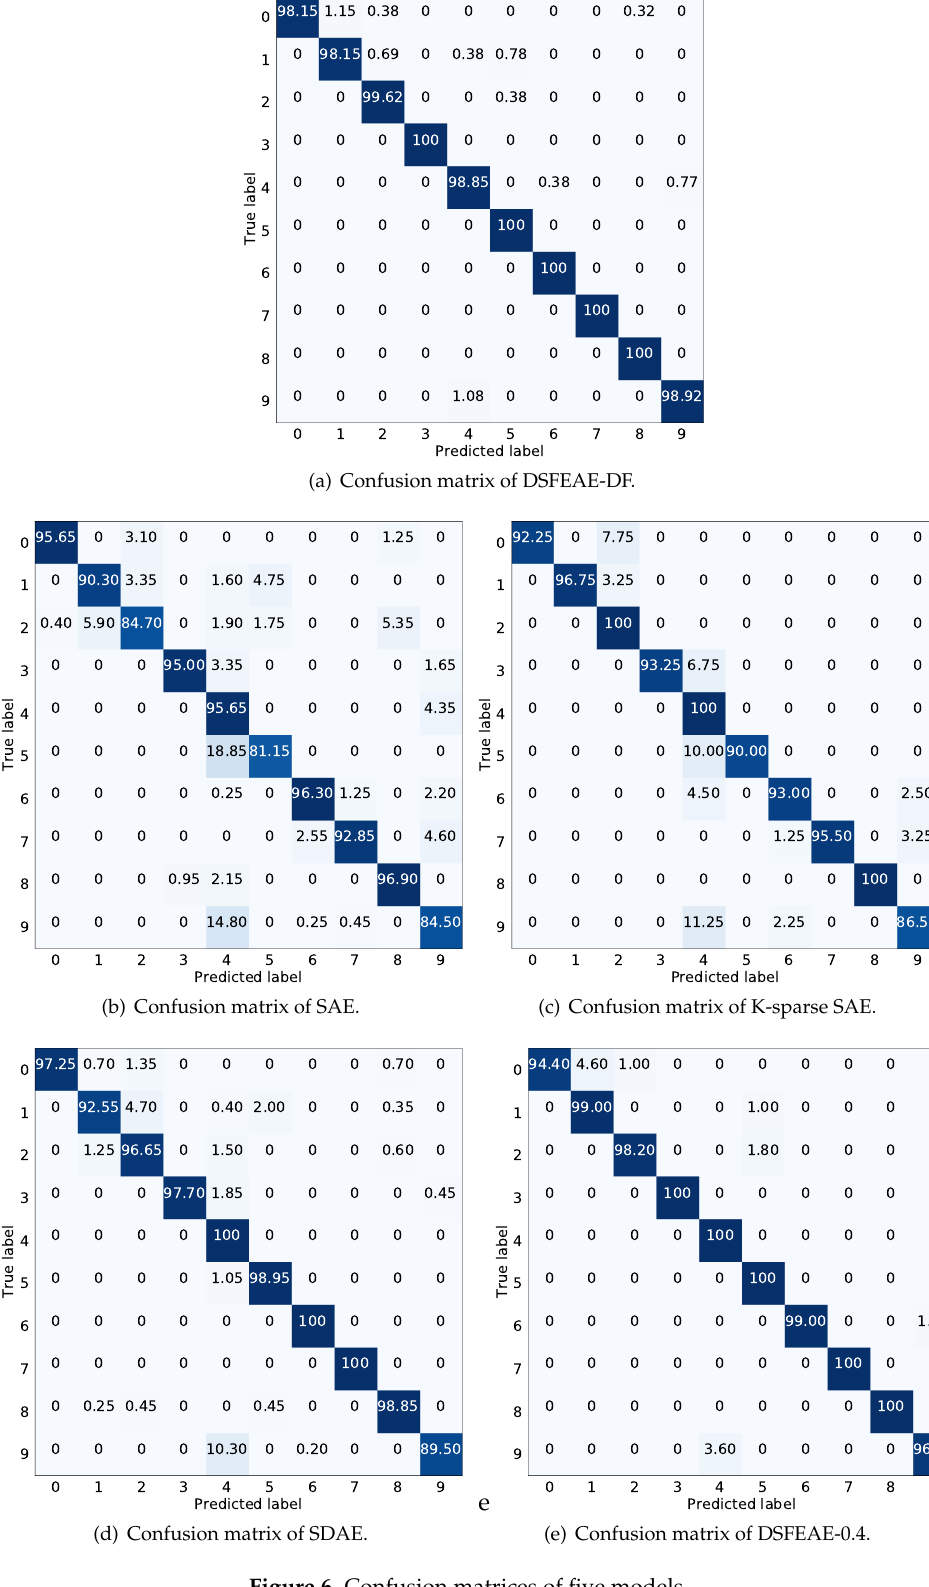
Figure 6. Confusion matrices of five